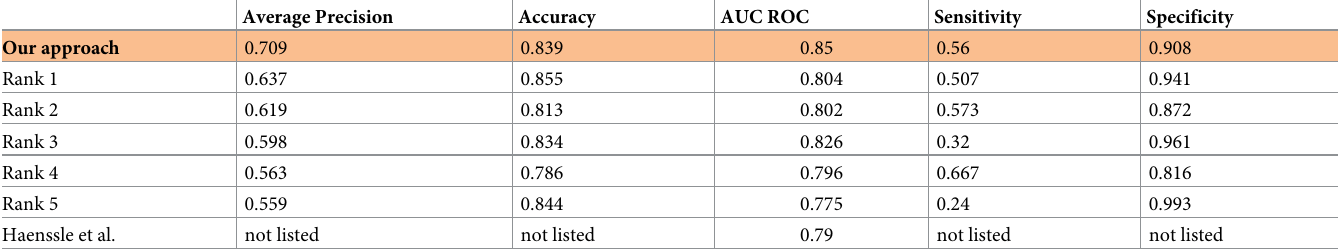
Table 1. Results of participants of the International Symposium on Biomedical Imaging (ISBI) 2016 challenge with the result published by Haenssle et